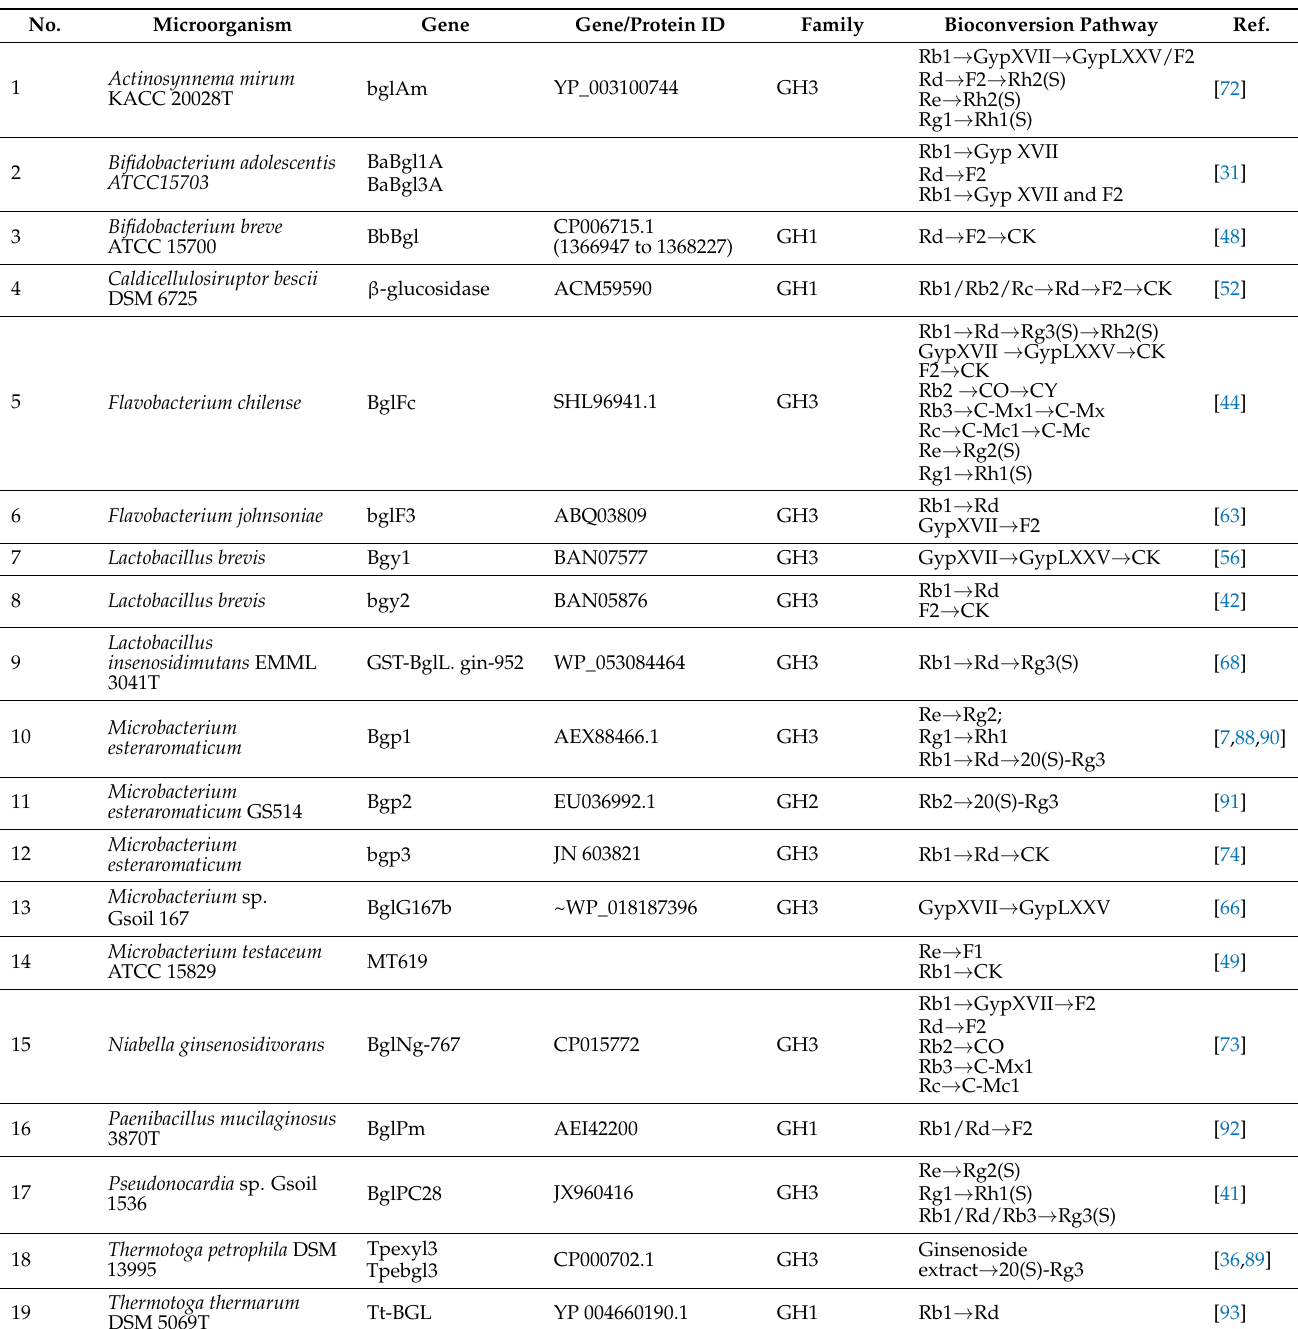
Table 2. Biotransformation of ginsenosides using β -glucosidase recombinant